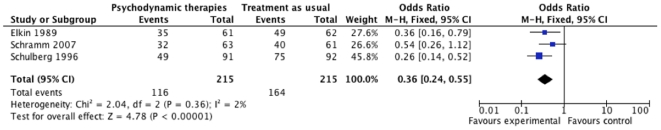
Effect of interpersonal psychotherapy on remission.Events: participants not remitting.